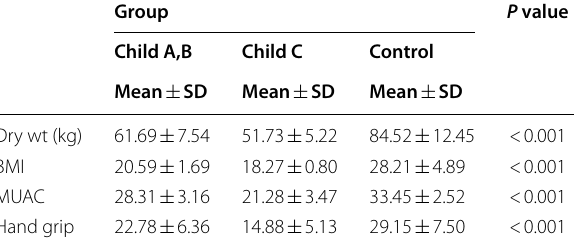
Table 4 Hand grip and anthropometric measures Group